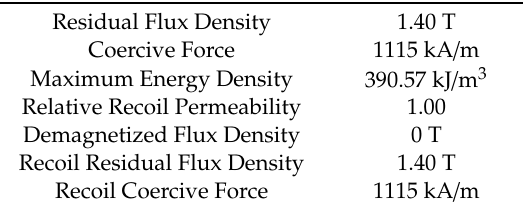
Table 3. Parameter combination possibilities of the examined operating points for validation of the analytical calculation method of the reluctance torque for IPMSM.